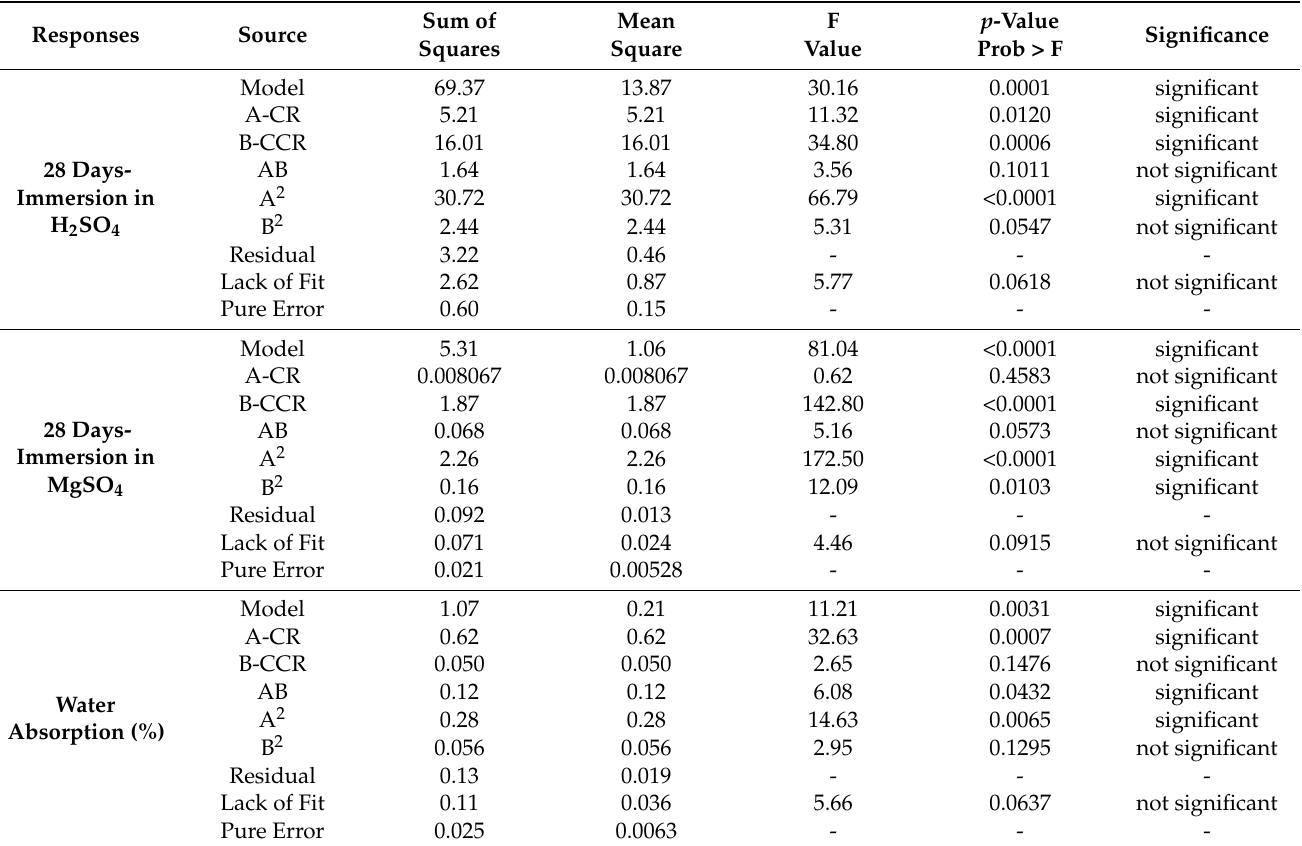
Table 4. ANOVA for durability responses